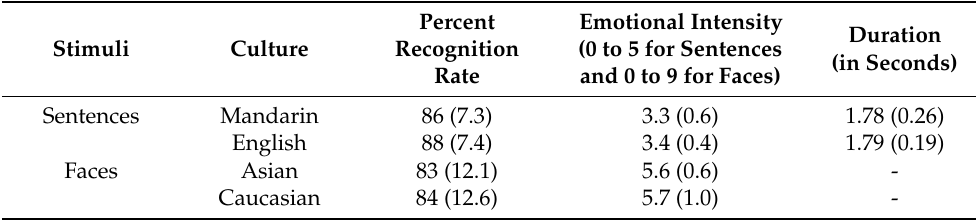
Table 1. Recognition accuracy and emotional intensity ratings for the sentences and faces from each culture. Stimuli Culture